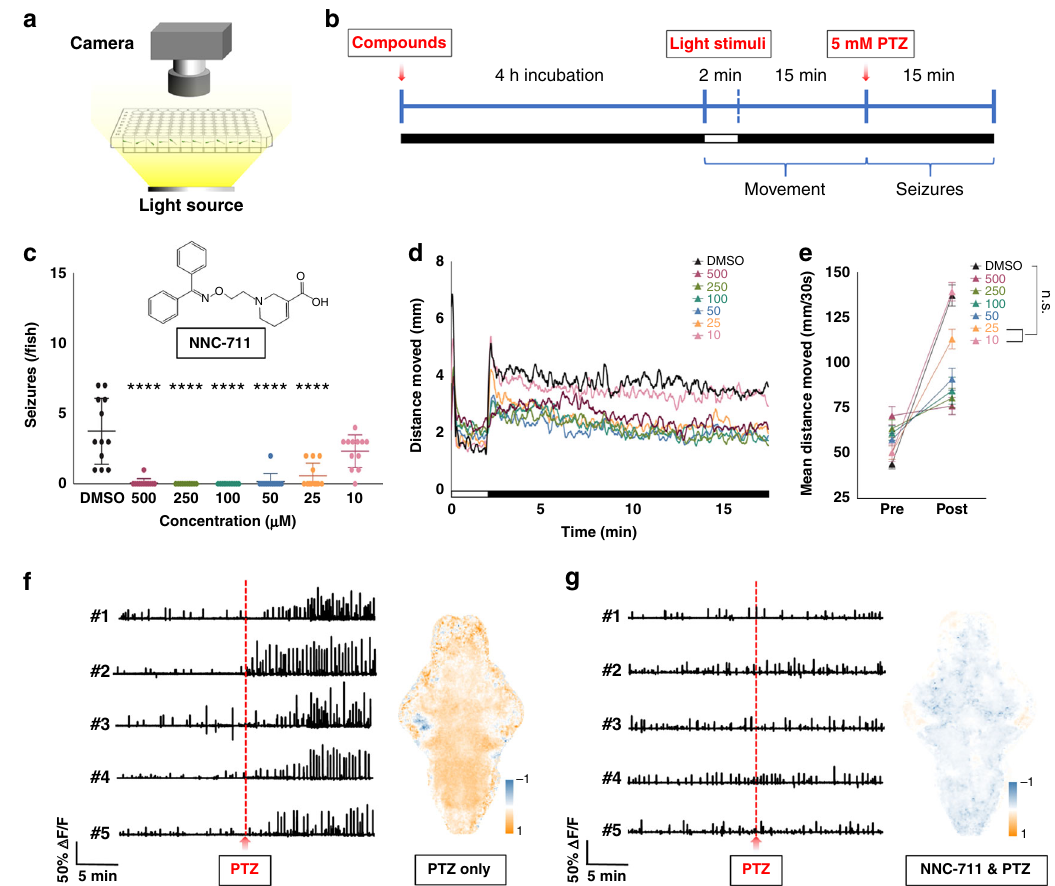
Fig. 6 Validation of the hit compounds using behavioral test in PTZ-seizure animal model. a Schematic of the setup for the behavioral test. b The experimental protocol. c The seizure count over 15 min in larvae exposed to 5 mM PTZ after 4-h preincubation with NNC-711 at different concentrations (10 ~ 500 μ M). A dose-dependent reduction in seizures is noted. Error bars indicate standard error of the mean (s.e.m.), n = 12, **** indicates p < 0.0001 by one-way ANOVA tests. d Representative results for the movement behavioral responses with NNC-711 preincubation at different concentrations (10 ~ 500 μ M). e The statistical analysis of the locomotive behavior of the larvae in response to the preincubation with NNC-711 at different concentrations (10 ~ 500 μ M). Each larva ’ s movement was monitored for 15 min after a 2 min light stimulation. Error bars indicate s.e.m., n = 12. Larvae treated with DMSO were used as a control, “ n.s. ” stands for no signi fi cant difference with p > 0.05 by ANOVA test. f Traces of calcium fl uctuation from fi ve larval brains and the associated T-score BAM showing the seizure activity induced by 5 mM PTZ treatment. g Traces of calcium fl uctuation from fi ve larval brain and the associated T-score BAM showing the reduction of seizure activity in PTZ-larvae by a 4 h treatment of NNC-711 at 10 µ